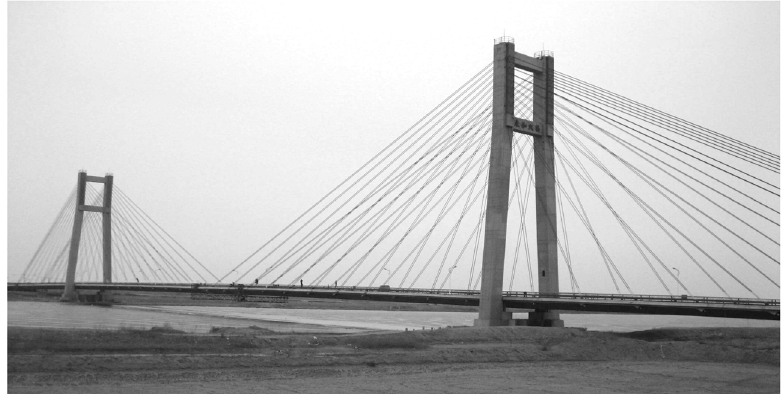
Figure 10. Tianjin Yonghe Bridge [154].